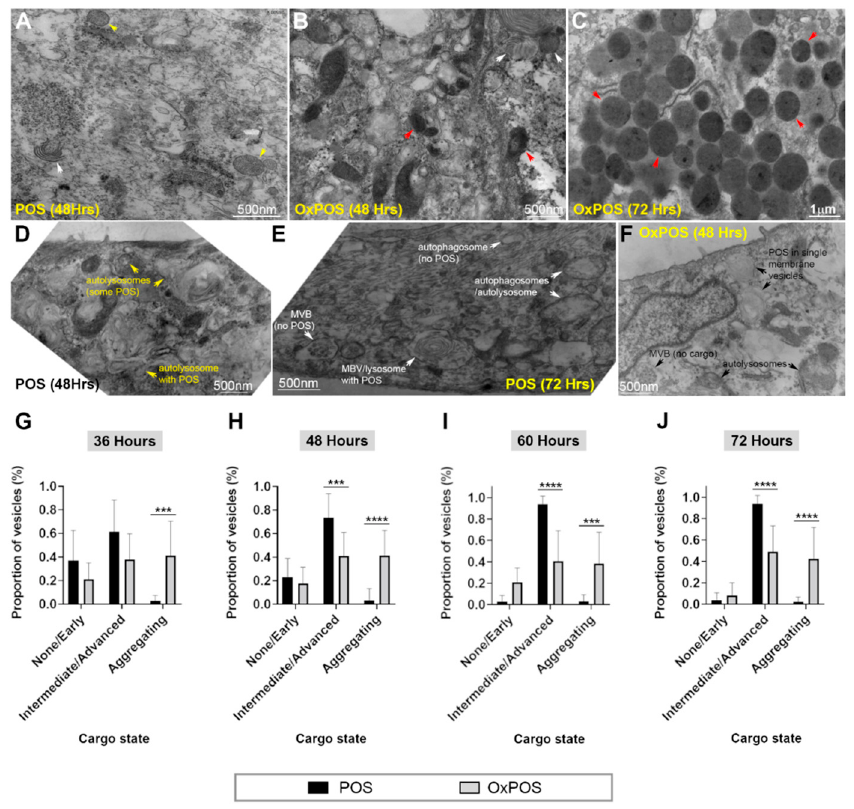
Figure 4. Ultrastructural evaluation of cargos within late compartments of RPE cells. The state of internalized cargos was assessed following exposure of cultured RPE cells to either POS or OxPOS. Morphological assessment revealed trafficked cargos that (1) showed no indication of breakdown or early degradation, (2) intermediate or advanced stages of breakdown or (3) displayed an aggregating phenotype. ( A ) A representative electron micrograph after 48 h, which show POS with characteristic fingerprint-like morphology and without obvious evidence of any degradation (white arrow). On occasion, vesicles containing uniform granular material were also observed (yellow arrows), presumably from endogenous content. ( B ) A representative electron micrograph of cells fed with OxPOS after 48 h shows some evidence of intermediate or advanced stages of cargo breakdown (white arrows), however a majority appear as electron-dense material (red arrows). ( C ) 72 h after cultured RPE cells were initially exposed to OxPOS, a significant proportion of vesicles appeared to contain cargos with a largely homogenous electron-dense morphology. ( D , E ) Representative electron micrographs showing POS cargos at 48 and 72 h in a variety of late compartments, including multivesicular bodies (MVBs) and autophagosomes / autolysosome-like structures. POS could be visualized in varying stages of degradation, whilst some compartments have no discernable cargo. ( F ) A representative electron micrograph showing evidence of OxPOS degradation at 48 h. Scale bars in A, B, D–F correspond to 500 nm, whilst scale bar in C corresponds to 1 µ m. Tra ffi cked cargos in blinded electron micrographs were grouped as described before, quantified and shown for ( G ) 36 h, ( H ) 48 h, ( I ) 60 h and ( J ) 72 h. As anticipated, the extent of POS breakdown increased over time. Although some OxPOS appeared to be degraded, a significant proportion formed conspicuous intracellular aggregates with a homogenous electron-dense morphology. These were present from the 36 h time point and persisted without obvious evidence of any degradation throughout the time course. For ease of categorizing, vesicles with endogenous material (yellow arrow in A) were grouped into the same category as aggregating OxPOS (red arrows in B–C). This method however, made no significant impact on the large number of aggregating OxPOS quantified in RPE cells. Data from a minimum of n = 10 fields / per time point. Statistical comparisons using a two-way ANOVA followed by Sidak’s multiple comparisons test, where significant di ff erences are indicated as p ≤ 0.001 (***) and p ≤ 0.0001